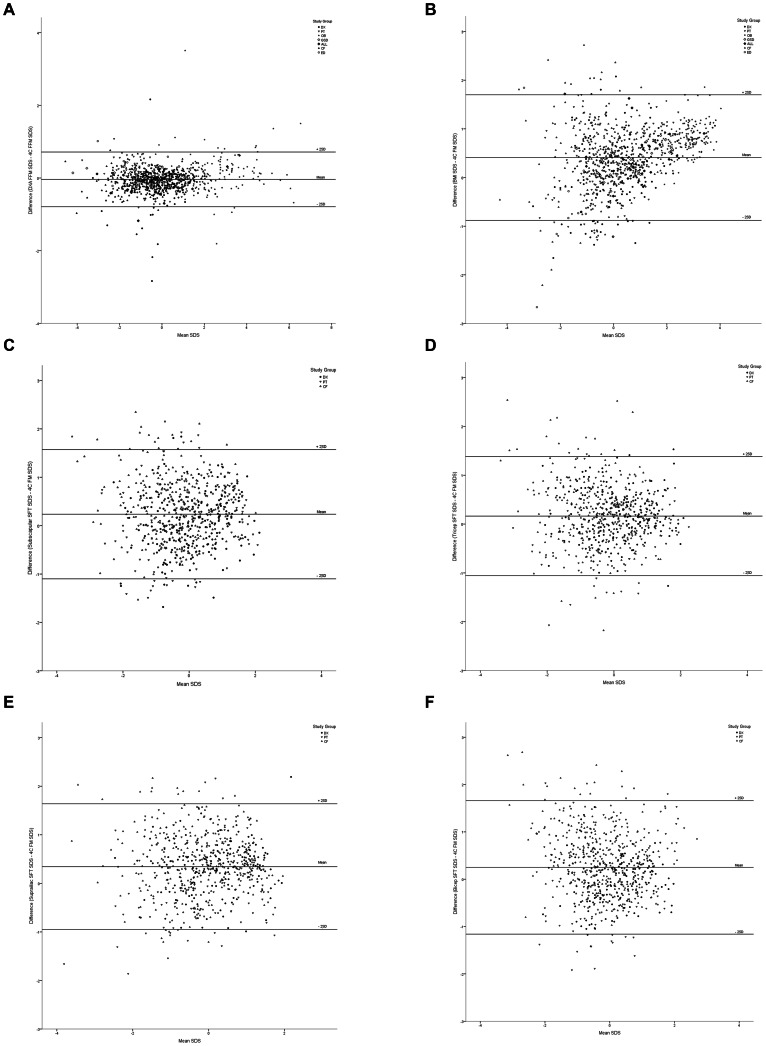
Bland-Altman analyses for the agreement between the 4C model and (A) DXA, (B) BMI, (C) bicep SFT, (D) tricep SFT, (E) subscapular SFT and (F) suprailiac SFT in the measurement of FM.SD scores (SDS) were calculated using ICH reference data [2]. Difference in SDS between techniques was calculated by subtracting 4C FM SDS from the FM SDS given by the ‘simpler’ method. Horizontal lines on the graph indicate the mean difference between techniques, and two standard deviations above and below this value. Different symbols indicate which study group each subject was from, as shown in the key. 4C model; four-compartment model, DXA; dual-energy X-ray absorptiometry, BMI; body mass index, SFT; skinfold thickness. DX; healthy children, PT; young adults born preterm, OB; obese children, GSD; glycogen storage disease, ALL; acute lymphoblastic leukaemia, CF; cystic fibrosis, ED; eating disorders. Evaluation of SFT as a measurement of FM was carried out using a limited population consisting of study groups DX, PBC and CF. The OB, GSD, ALL and ED studies did not include SFT measurement as part of their protocols. Since no subjects were available for the overweight disease group, normal subjects were compared to underweight subjects only.